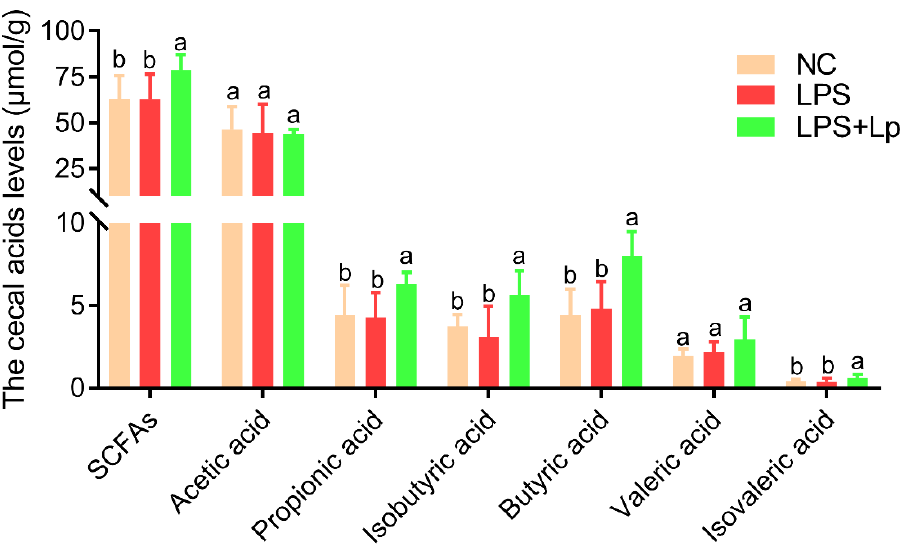
Figure 4. Effect of L. paracasei CCFM1223 pretreatment on the cecal SCFAs levels in LPS-treated mice (n = 8). Values with different letters are significantly different ( p <